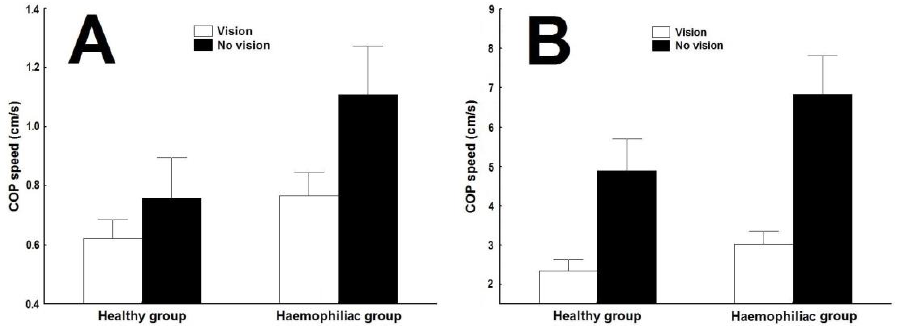
Figure 1. Mean speed of the centre of pressure (COP Speed) for healthy and haemophiliac groups in ( A ) hard floor and ( B ) foam floor conditions. Error bars are ±95% confidence intervals.